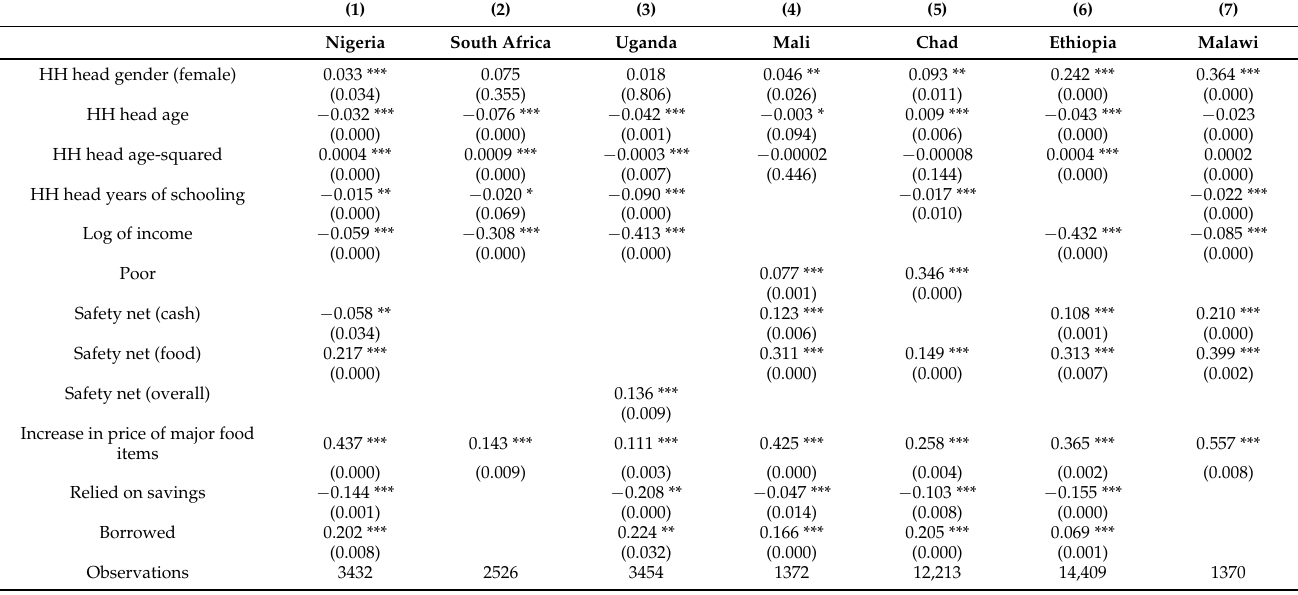
Table A3. Determinants of food insecurity—ran out of food.